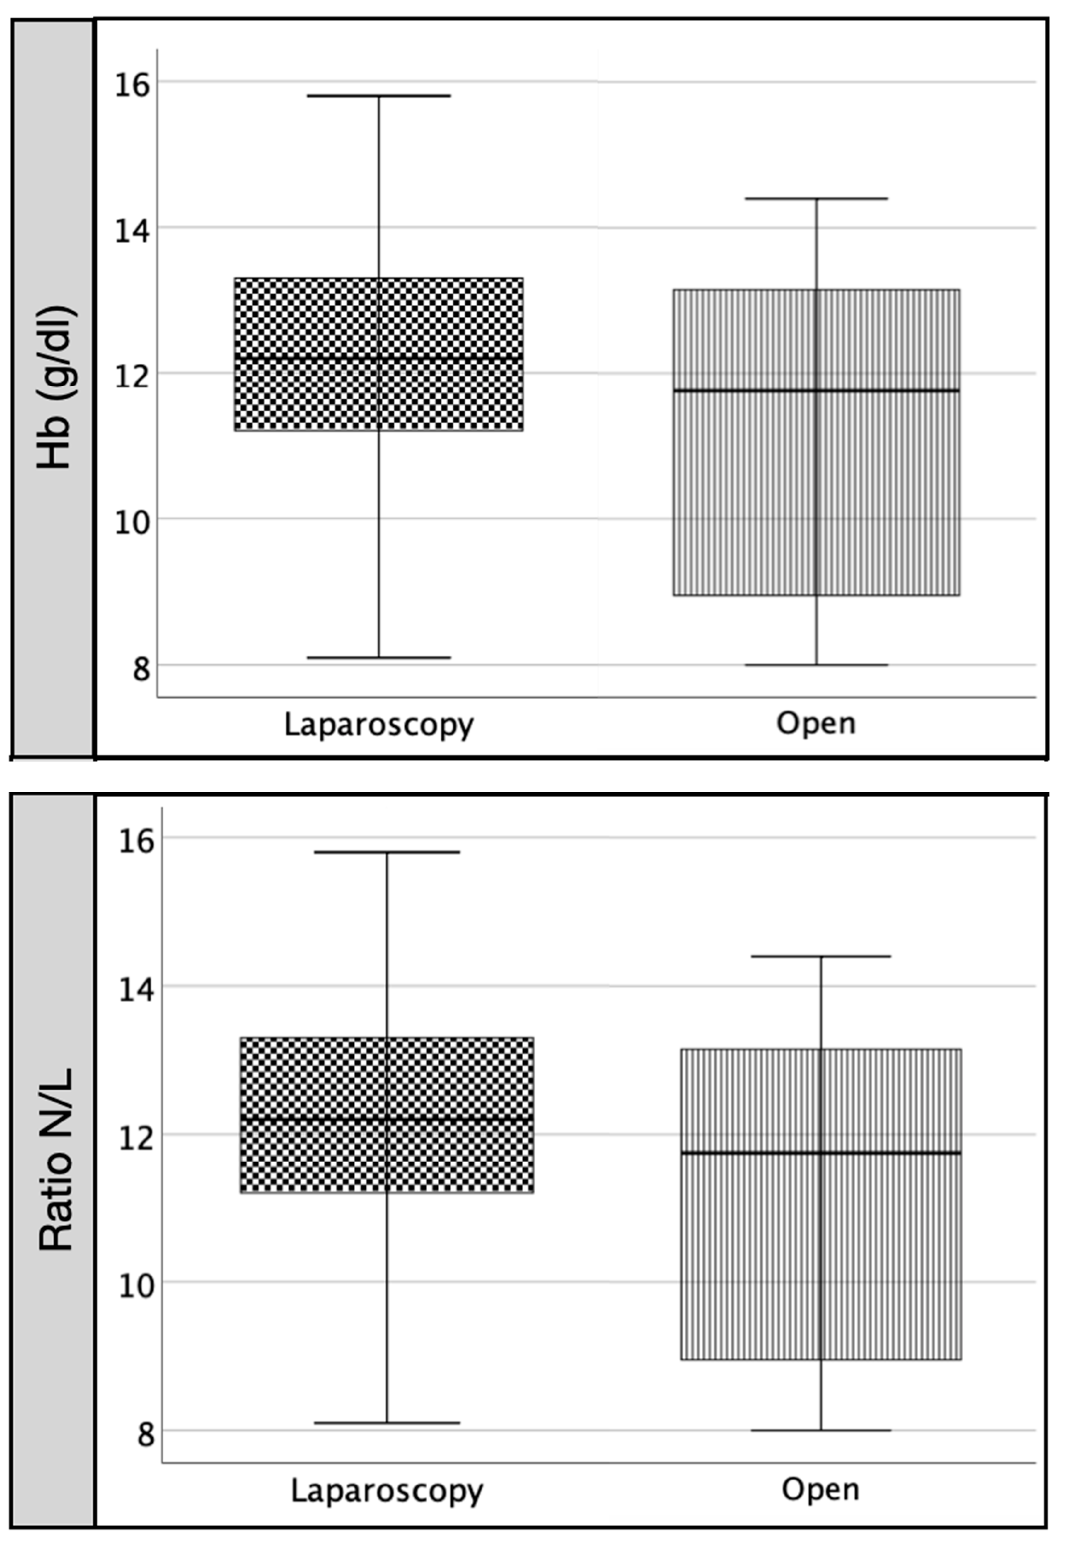
Figure 3. Comparison between LC and OC at postoperative day 1 (A2): hemoglobin and N/L ratio. Legend: Comparing open (OC) versus laparoscopy (LC) group 24 h after surgery (A2), we do not find differences in Hb, but there in OC there is a non-significant increase in N/L ratio.